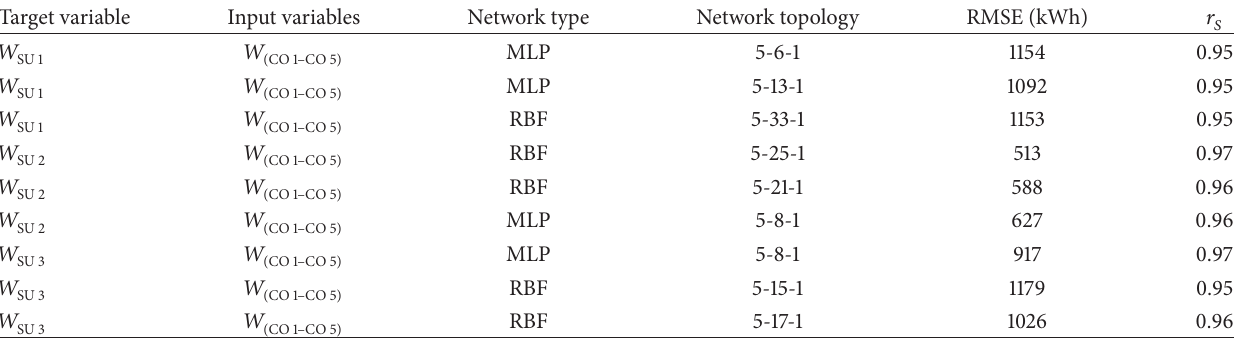
Table 8: Summary of the results for the target site Suedlohn in the Westphalian Basin within the area of the North German Plain.